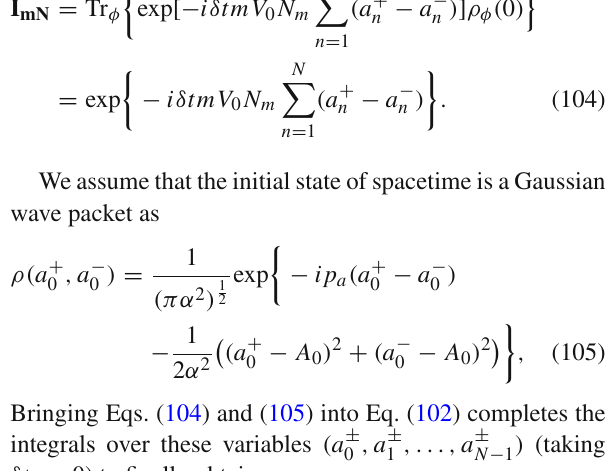
Fig. 20 Variations in the relative quantum fluctuation. The horizontal and vertical axes represent the time variable and relative fluctuation, respectively. The parameters are taken as: α = 1, V 0 = π